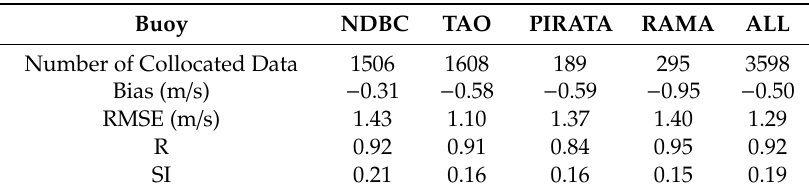
Table 3. WS errors between Jason-3 and moored